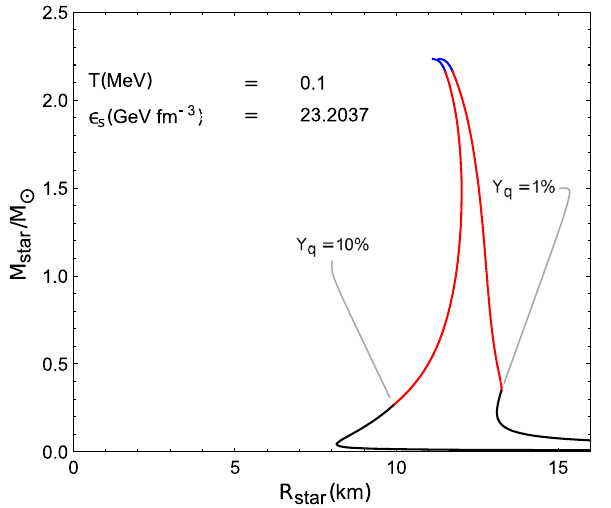
Fig. 7 MR diagram of NS with multiquark core and nuclear crust with FYSS EoS at T = 0 . 10 MeV ture is T surf = 0 . 5643 (0.546-0.549) T 0 for the CET (FYSS)